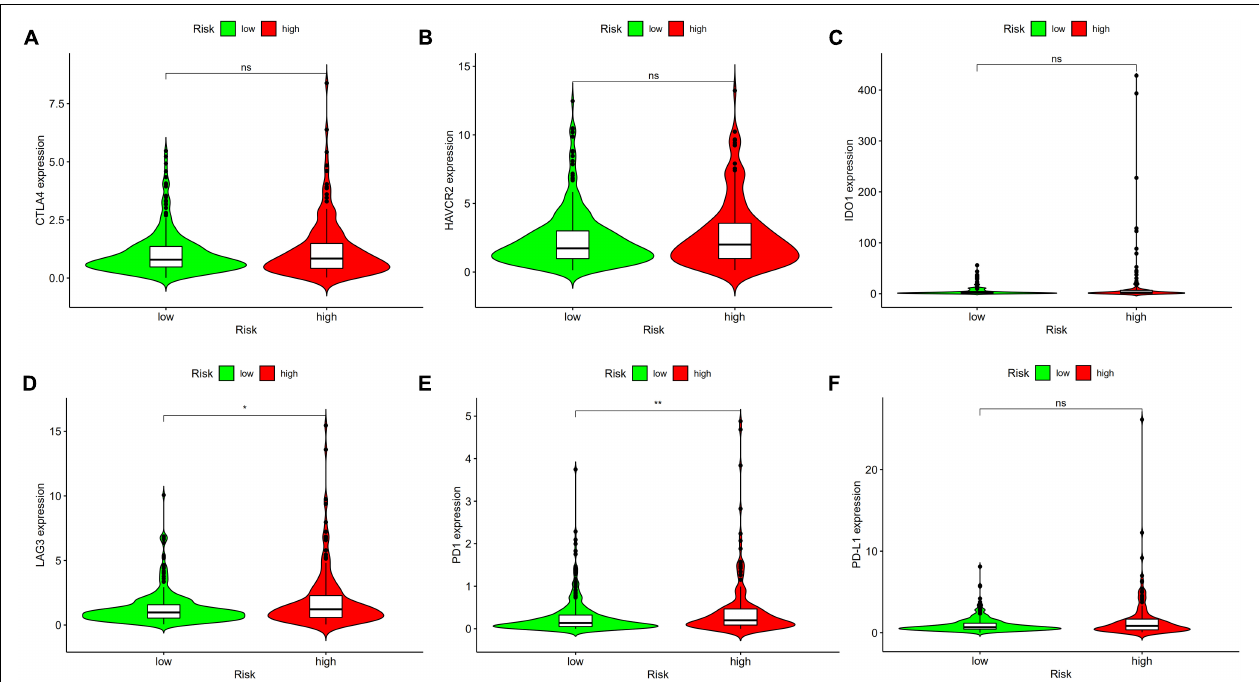
FIGURE 9 | High risk scores were positively correlated with upregulated (D) lymphocyte-activation gene 3 (LAG3) and (E) programmed cell death protein 1 (PD1) levels, whereas the other plots showed no statistical difference in patients with colon cancer (A–C,F) . * p < 0.05; ** p < 0.01.